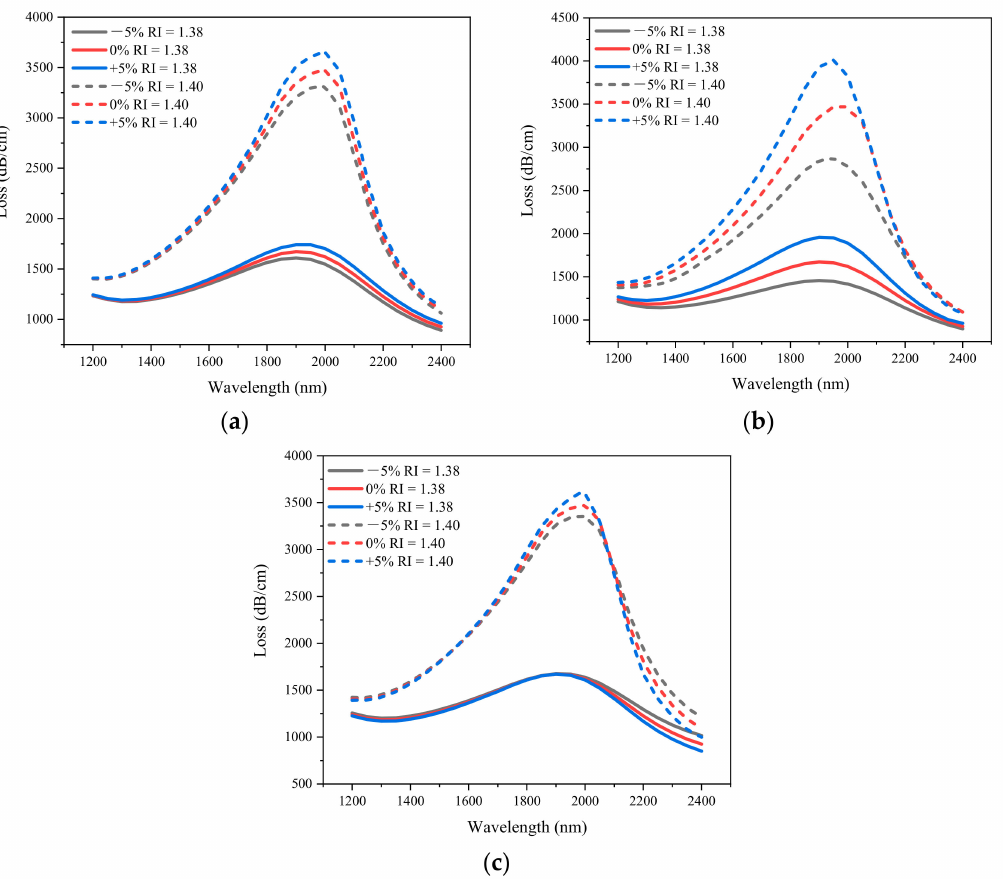
Figure 8. The effect of diameter on confinement loss obtained by simulation. ( a ) d 1 ; ( b ) d 2 ; ( c ) d 3 . (The solid line represents the confinement loss when the analyte RI is 1.38, and the dotted line represents the confinement loss when the analyte RI is 1.40; Λ = 2 µ m, tz = 25 nm, ts = 30